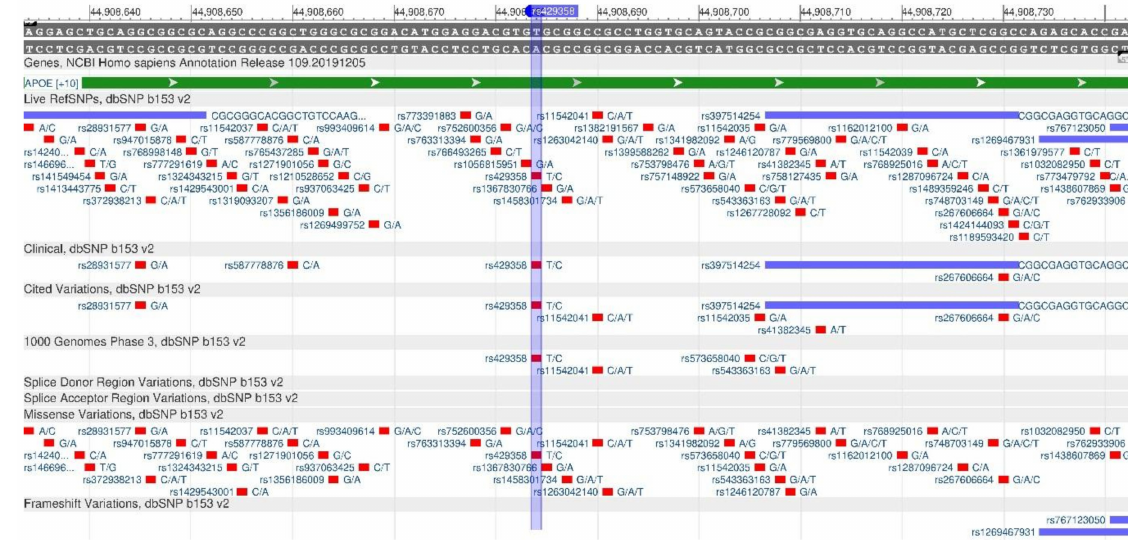
Figure 12. ApoE gene region (located on the long (q) arm of chromosome 19) containing the oligonucleotide polymorphism rs429358.